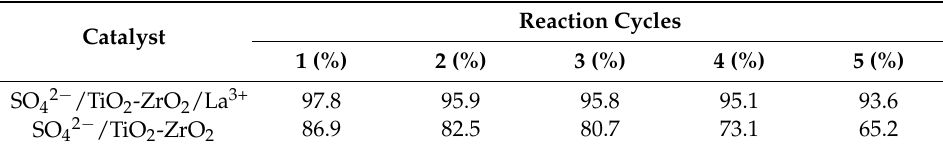
Table 8. Stability of the catalyst.